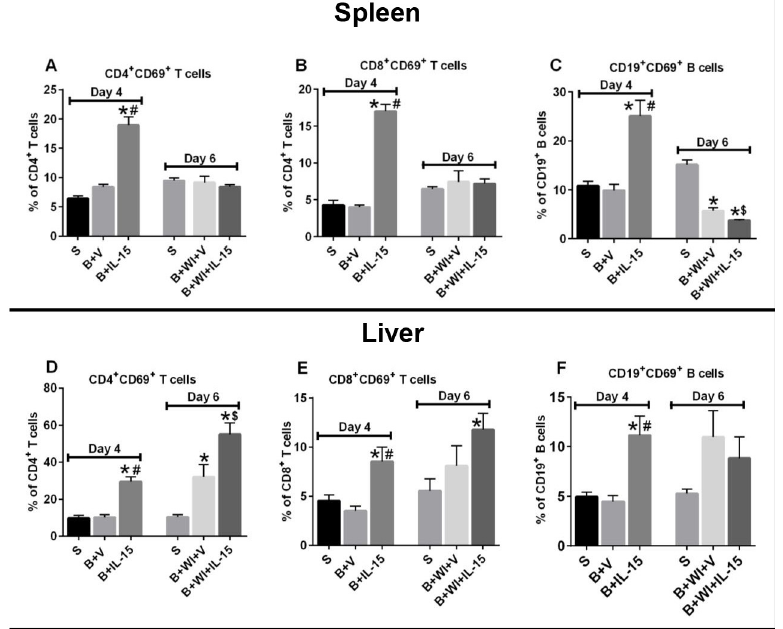
Fig 4. Effect of burn injury and wound infection with or without IL-15 SA treatment on CD4 + , CD8 + T and CD19 + B lymphocytes activation status. CD69 surface expression was used as a marker of cellular activation and measured by flow cytometry. Upper half of the panel depicts data for spleen cells and lower half of the panel depicts data for liver tissue. Percentage of CD69 expression was measured on CD4 + T cells (A and D) , CD8 + T cells (B and E ), and CD3 - CD19 + B cells (C and F ); in the spleen and liver. n = 8 – 12 in each group and P < 0.05. * significantly different as compared to respective day 4 and day 6 sham groups; #significantly different from day 4 burn injury group (B+V), and $ — significantly different from day 6 burn injury + wound infection + vehicle treated group